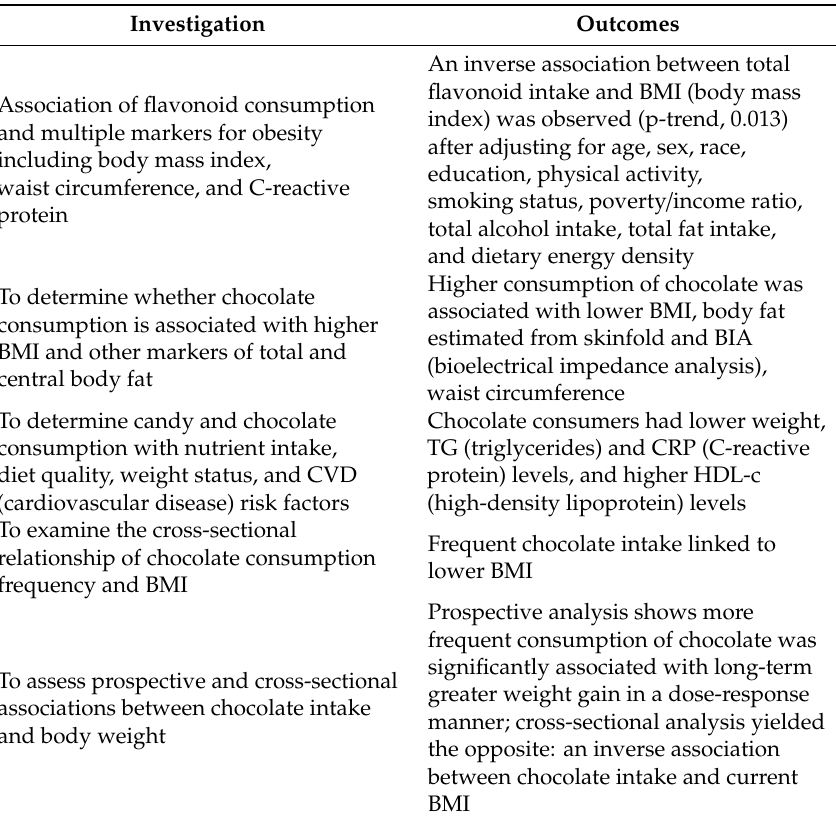
Table 3. Characteristics and outcomes of observational